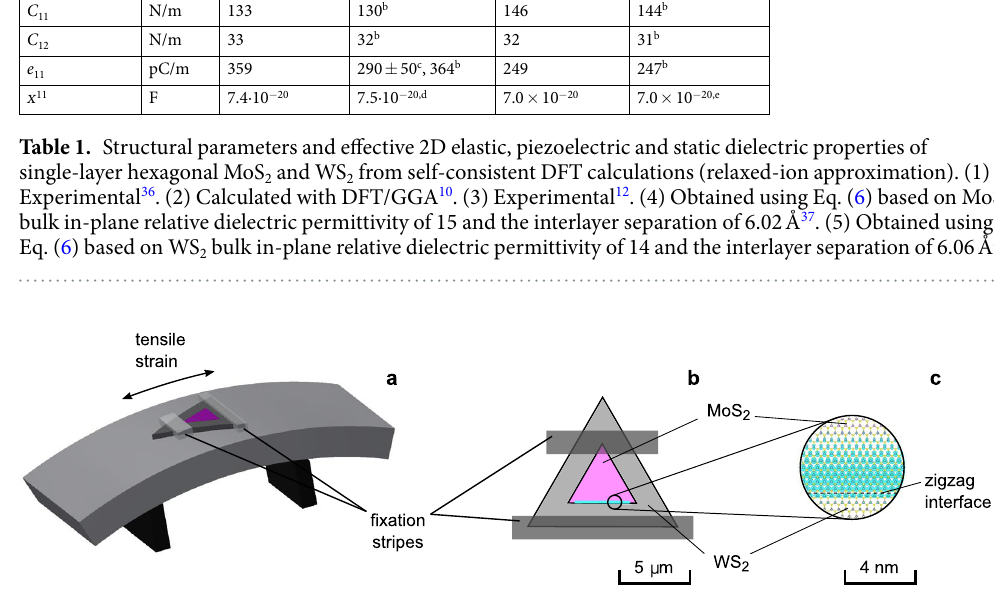
Figure 4. ( a ) Schematic illustration of a four-point bending setup for straining a triangular MoS 2 /WS 2 lateral heterosctructure. ( b , c ) 1DEG is formed at the zigzag interface oriented perpendicular to the applied